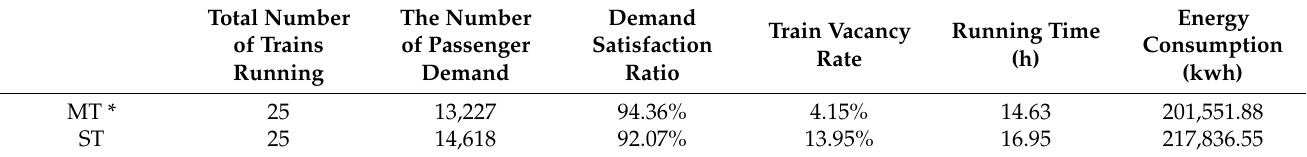
Table 11. Comparison of metrics under scenario 2.